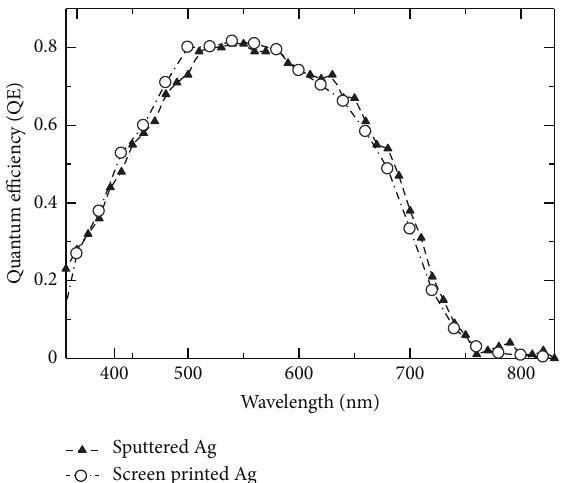
Figure 6: Quantum efficiency of flexible n-i-p amorphous silicon solar cell using sputtered Ag and screen printed Ag back